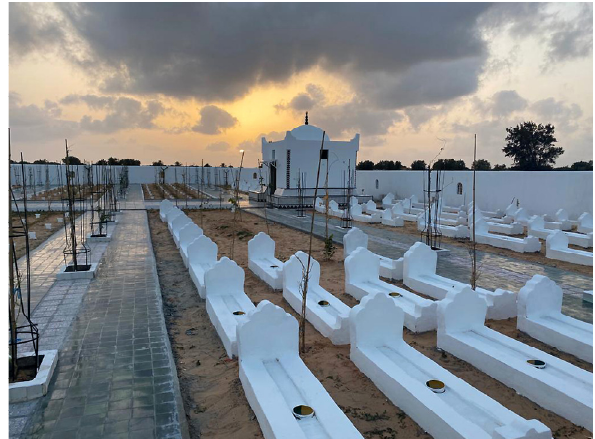
Figure 15. View of the garden cemetery and multi-faith prayer room at the far end, Le Jardin d’Afrique , Zarzis, Tunisia. 2021. © Rachid Koraïchi.